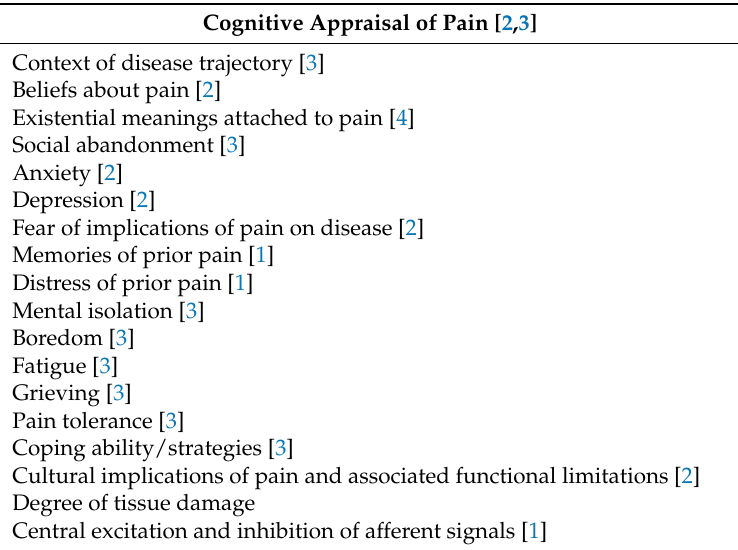
Table 1. Factors contributing to experience of pain in children.